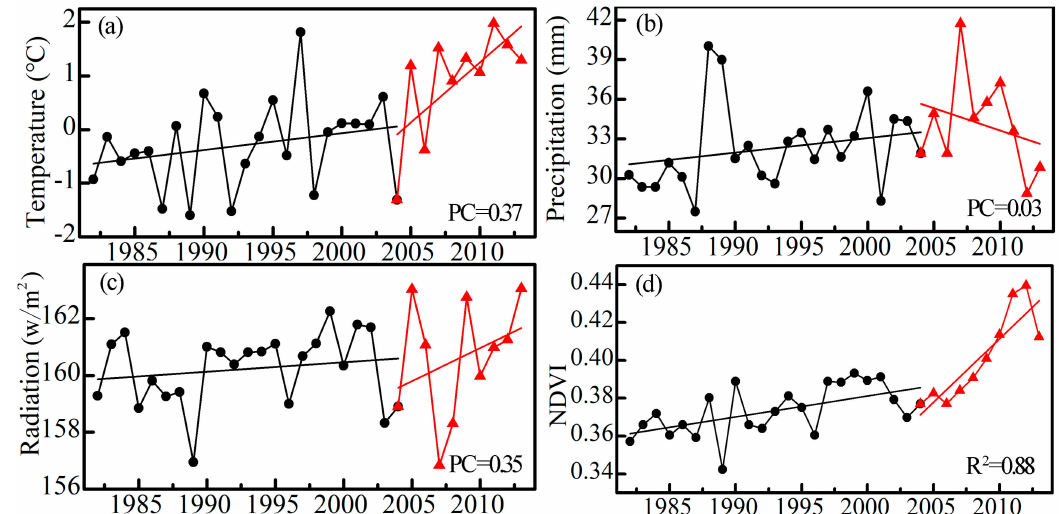
Figure 10. Climatic factors and NDVI variations in northern Russia from 1982–2013. ( a ) Temperature (T); ( b ) precipitation (P); ( c ) radiation (R); and ( d ) NDVI; the black line and the red line represents the changing trends before and after the temperature change. The red line represents the changing trend after the temperature changes. PC represents the partial correlation coefficient of each climatic factor with NDVI, excluding the other two meteorological variables, and R 2 represents the coefficient of determination between the NDVI and the meteorological factors. The relationship between NDVI and the climate factors is NDVI = 0.015T − 0.00055P + 0.003R −